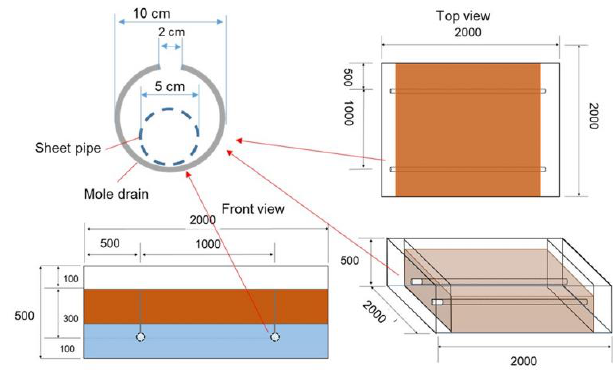
Fig. 1 Experimental model of subsurface